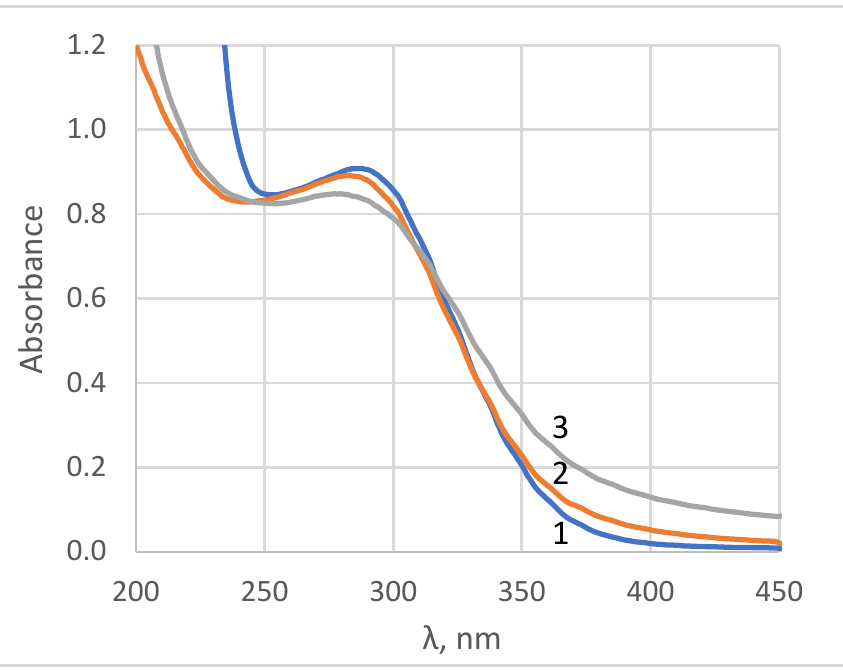
Figure 2. UV-vis spectra of gadolinium-doped ceria sols, Samples 1–3.